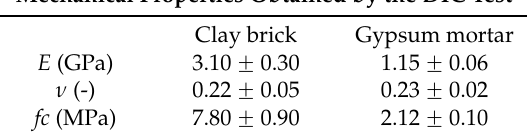
Table 2. Mechanical properties obtained by the performed DIC